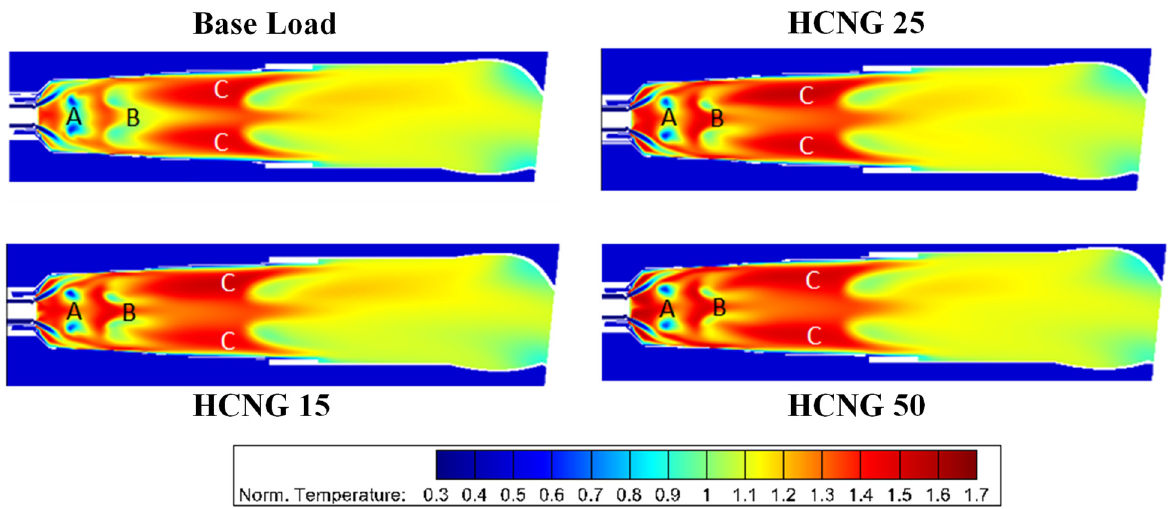
Figure 15. Normalized temperature contours—slice 3. Letters A–C denote specific regions as explained in the text.